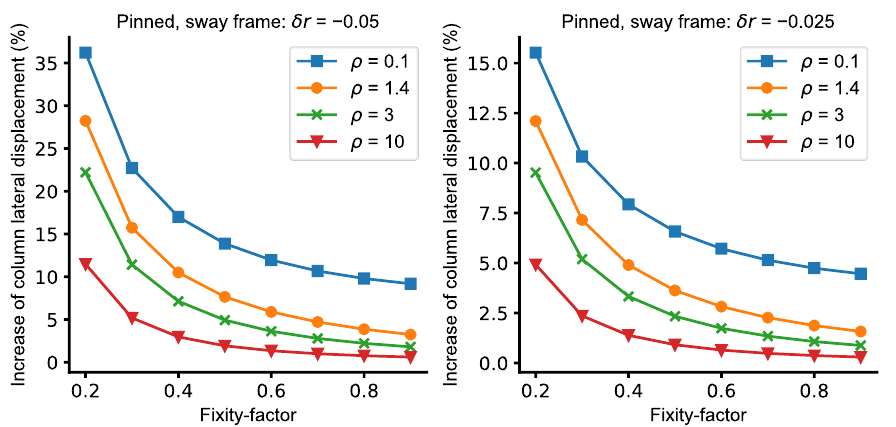
Figure 7 . Increase of column lateral displacement due to the negative deviation of